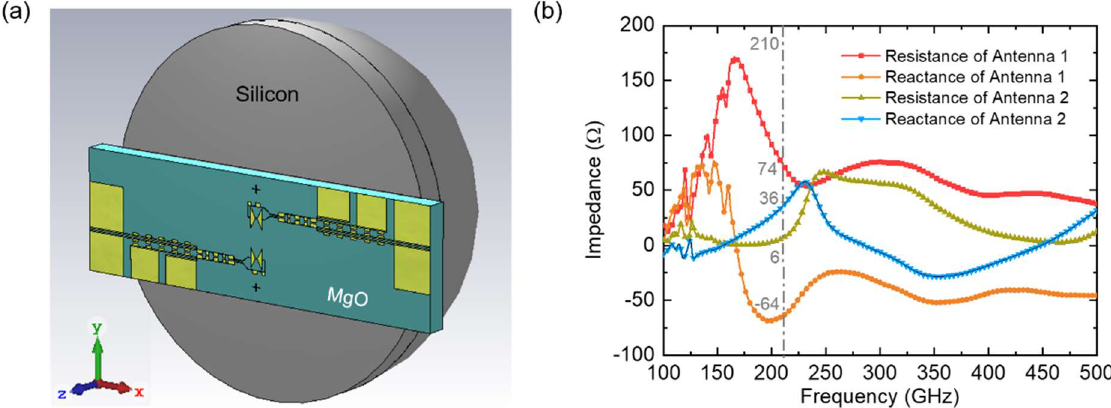
Figure 7. ( a ) Model of the actual mixer chip attached to a Si hyper-hemispherical lens in CST MWS. ( b ) Simulated input impedances where HTS JJs locate in ( a ) model.